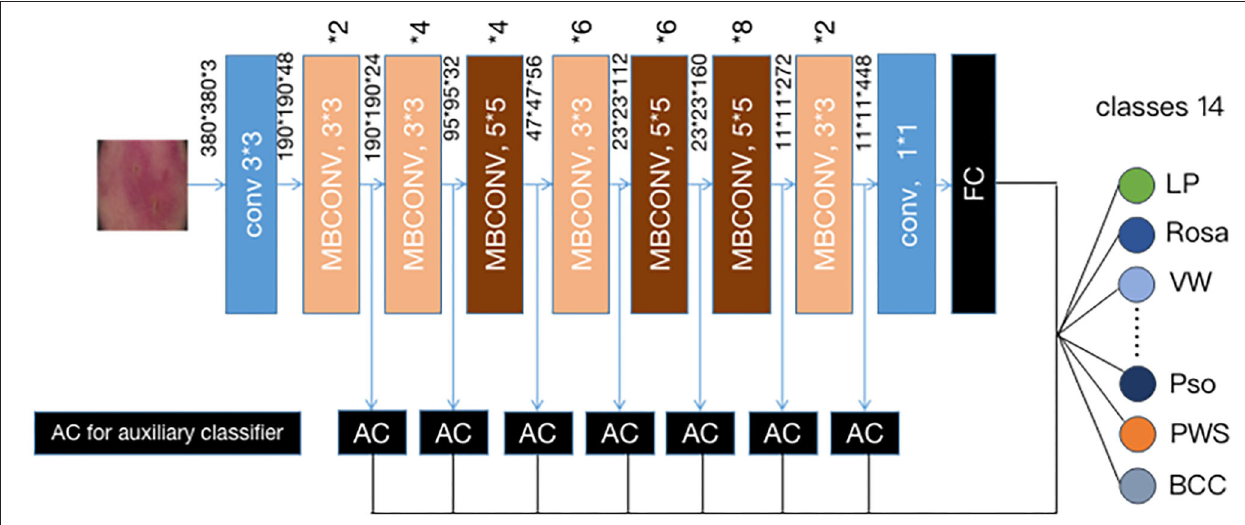
FIGURE 2 | Our modified (19) EFFICIENTNET-b4 architecture. Data flow is from left to right: a dermoscopic image is put into the network and finally transformed into a probability distribution over clinical classes of skin disease using our modified EfficientNet-b4 architecture pretrained on the ImageNet dataset and fine-tuned on our own dataset of 13,603 dermoscopic images in 14 categories.